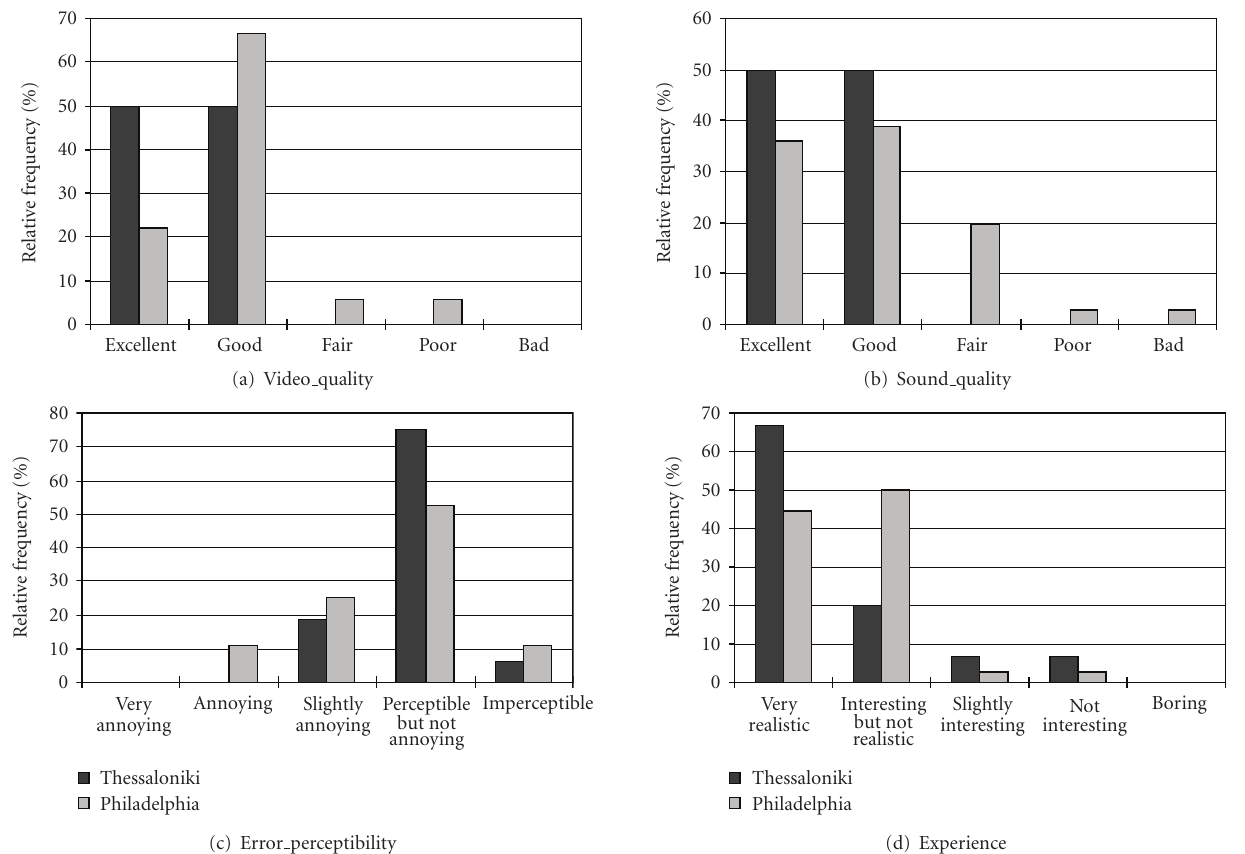
Figure 5: Qualitative evaluation results: (a) video quality (b) sound quality (c) perceptibility of errors and impairments (d) total experience.